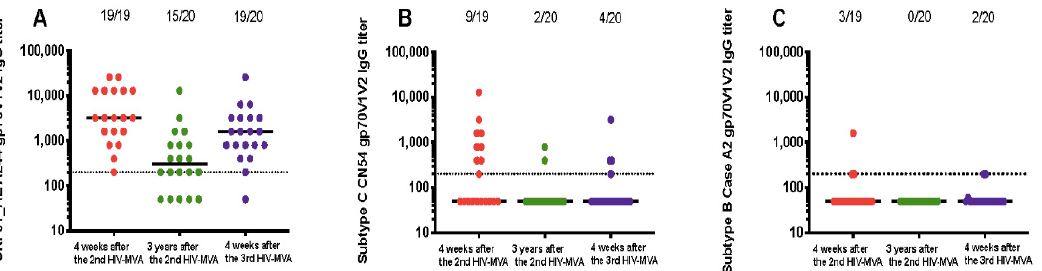
Figure 2. Durability of binding IgG responses to V1V2 scaffolds. Response rates against gp70V1V2 region of CRF01_AE A244 ( A ) subtype C CN54 ( B ) and subtype B Case A2 ( C ) as detected by ELISA at four weeks post second HIV-MVA vaccination (V21, response in red circles), three years after the second HIV-MVA immunization (V62, response in green circles) and four weeks after the third HIV-MVA boost (V64, response in purple circles). Horizontal solid lines represent the median titers of antibody responses at di ff erent time points, while dotted line indicates a cut o ff for positive values. For graphing purposes, negative samples were arbitrarily given a value of